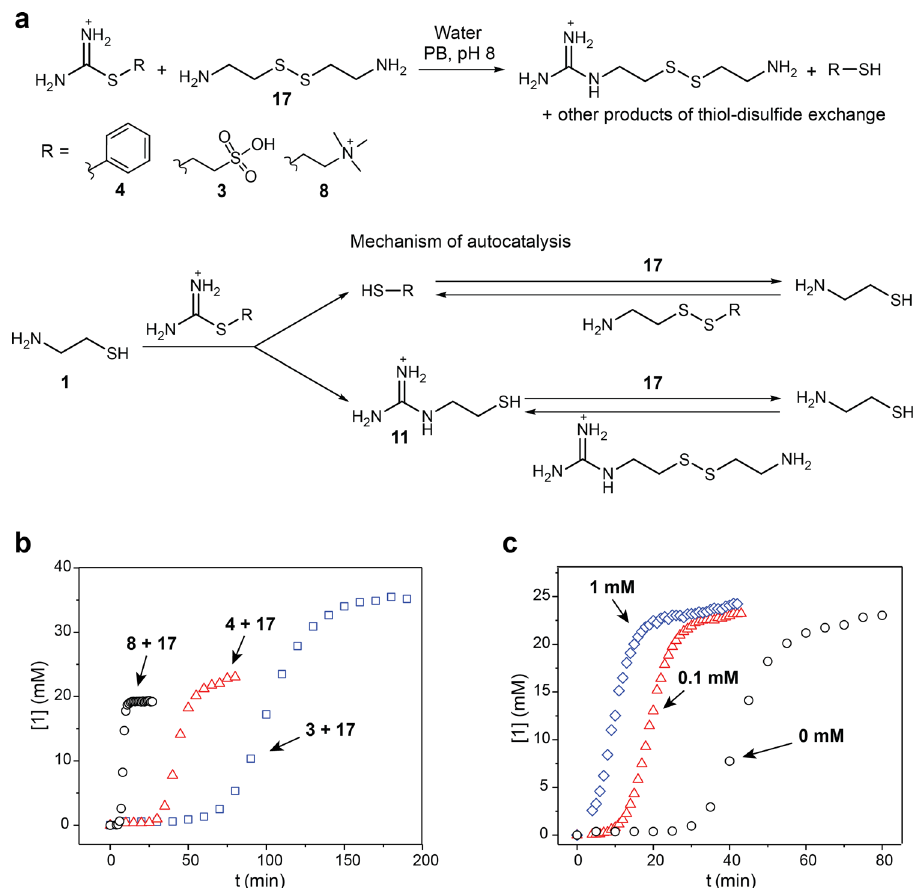
Fig. 3 Autocatalytic reactions of thiouronium salts with cystamine (17). a The general scheme of the reactions between thiouronium salts 3 , 4 , 8 , and 17 . The mechanism underlying the exponential growth of a concentration of 1 . b The kinetics of the reactions of 3 , 4 , and 8 with 17 . We monitored the kinetics of these reactions by following the production of 1 by 1 H NMR spectroscopy. Reactions conditions: D 2 O, 1 M PB pH 8, 25 °C, ([ 3 ] = 50 mM; [ 17 ] =